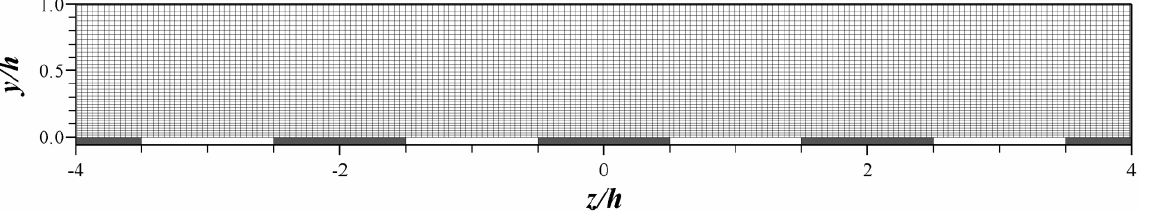
Figure 3. Cross-sectional view of the fine grid (only every 3rd grid line is